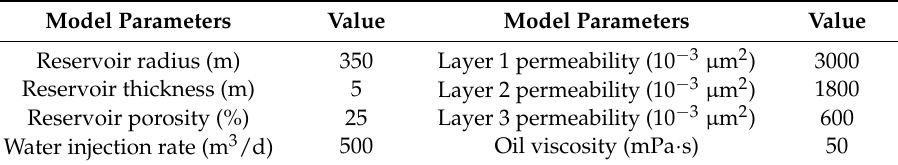
Table 1. Main parameters of the